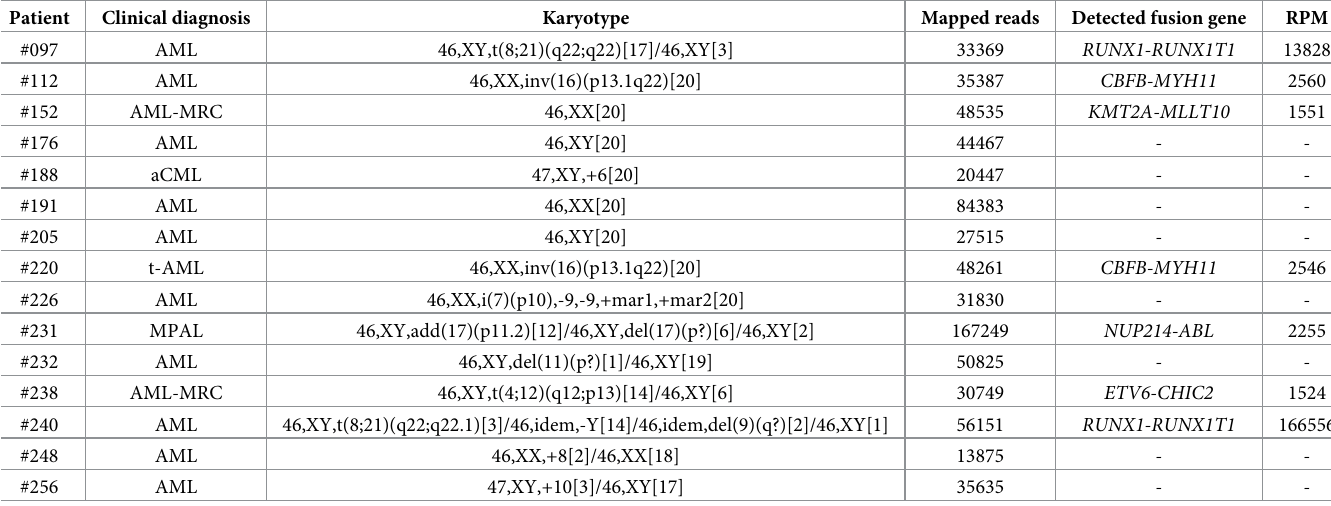
Table 3. List of patients, karyotypes, and fusion genes detected in the RNA target sequencing data of the smear